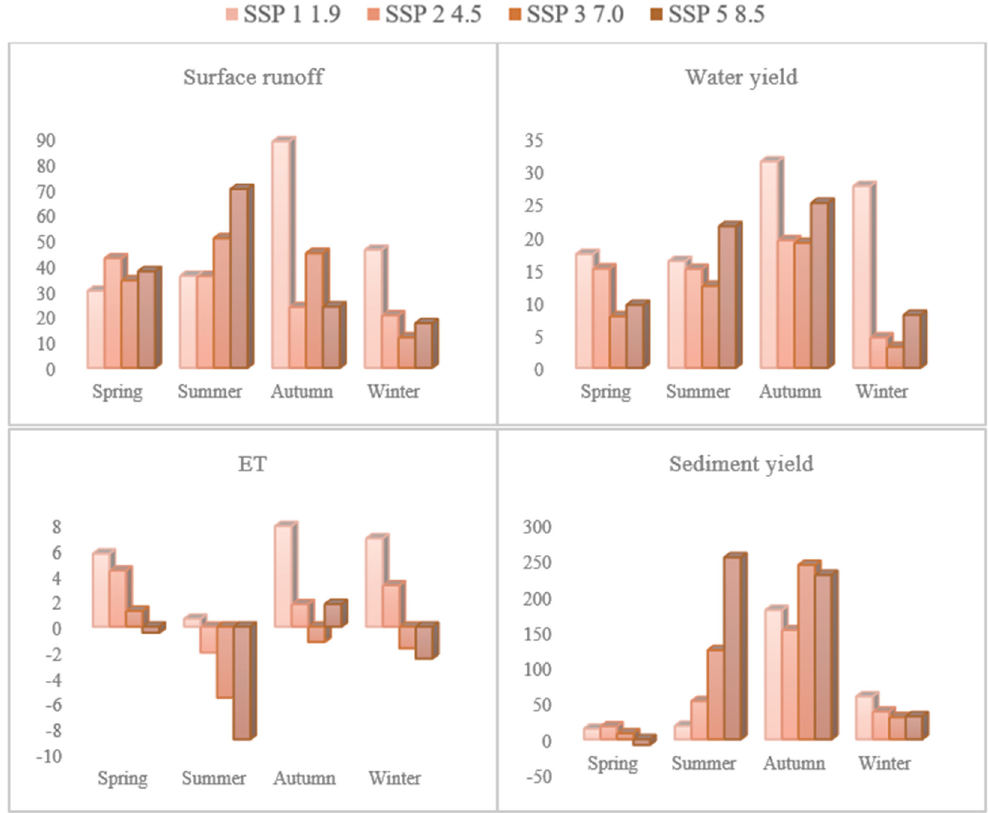
Figure 7. Impacts of precipitation, temperature, and atmospheric [CO 2 ] at seasonal scale. River Flow